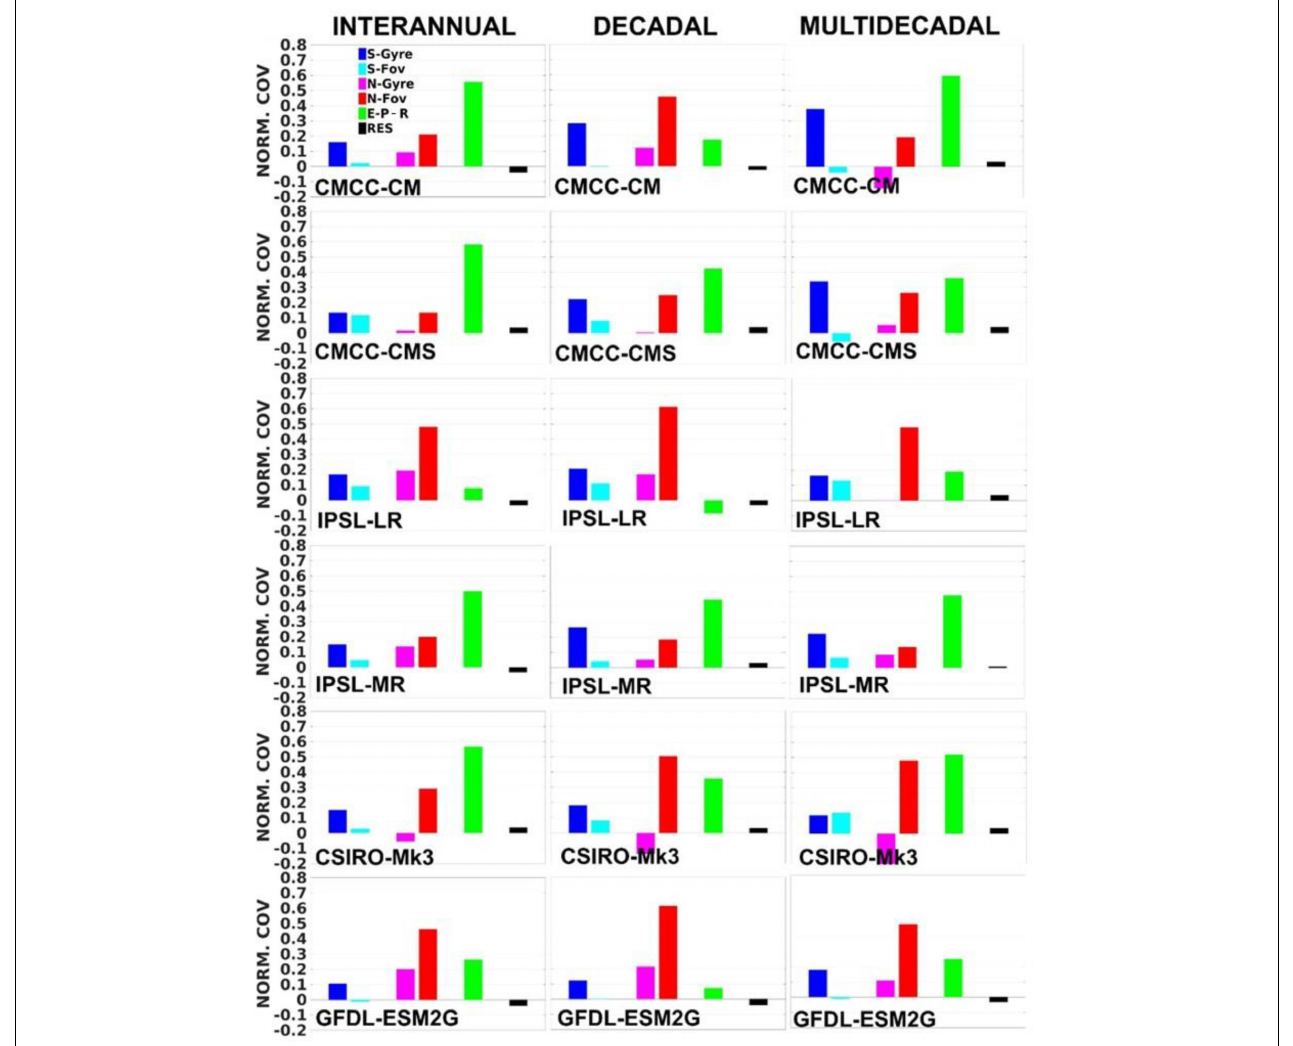
FIGURE 6 | The covariance of each budget term with FWC changes normalised by the variance of FWC changes (Eq. 8, considering the region between 34 ◦ S and 40 ◦ N). The sum of all normalised covariances, including from the residual term, equals 1. The normalised covariances are evaluated on interannual, decadal, and multidecadal timescales. The prefixes “S-” and “N-” denote southern and northern transports, respectively.